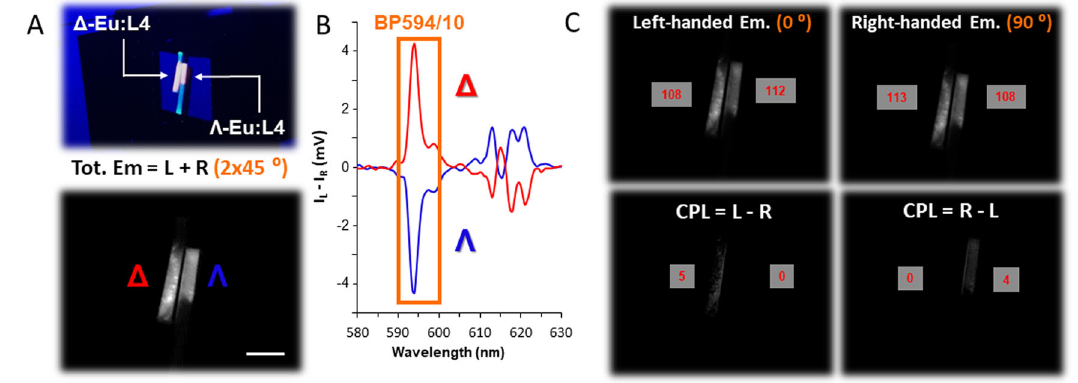
Fig. 4 | Solid state time-resolved EDCC photography of a CPL active Eu(III) complex on paper substrate. A (top) Conventional photo and (bottom) time- resolved CPLP of Λ and Δ -Eu:L4 in embedded into optical brightener free paper (c=5×10 − 6 M) using 365nm UV illumination from the smooth side of the paper. Scale bar=0.5cm. B CPL emission spectraof Δ - (red) and Λ - (blue) enantiomers of Eu:L4 in MeOH ( λ exc = 365nm) highlighting the spectral window selected for